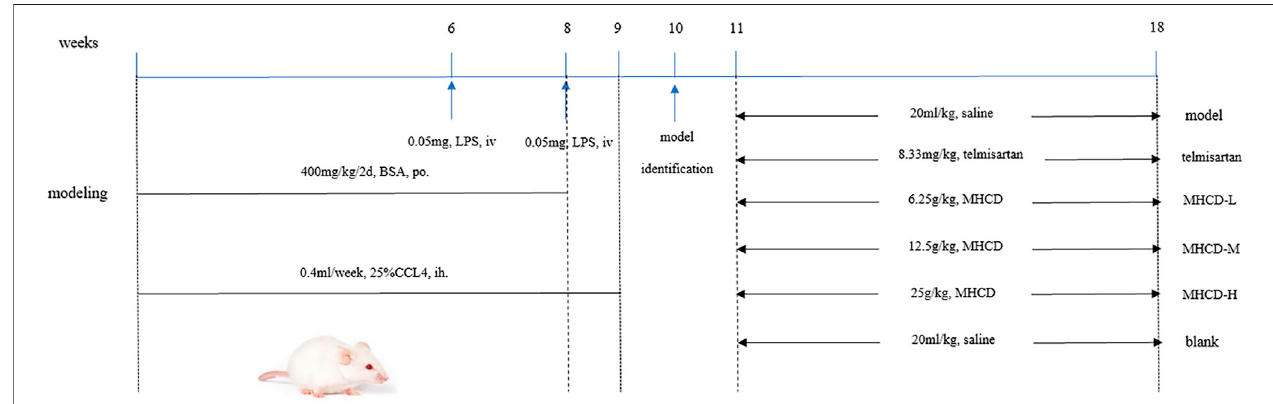
FIGURE 1 | Protocol of IgAN rat modeling and treatment. After oral administration of BSA for 8 weeks, hypodermic injection of CCl4 for 9 weeks and two times of LPS with tail intravenous injection, the IgAN rats were orally administered different drugs for 8 weeks.